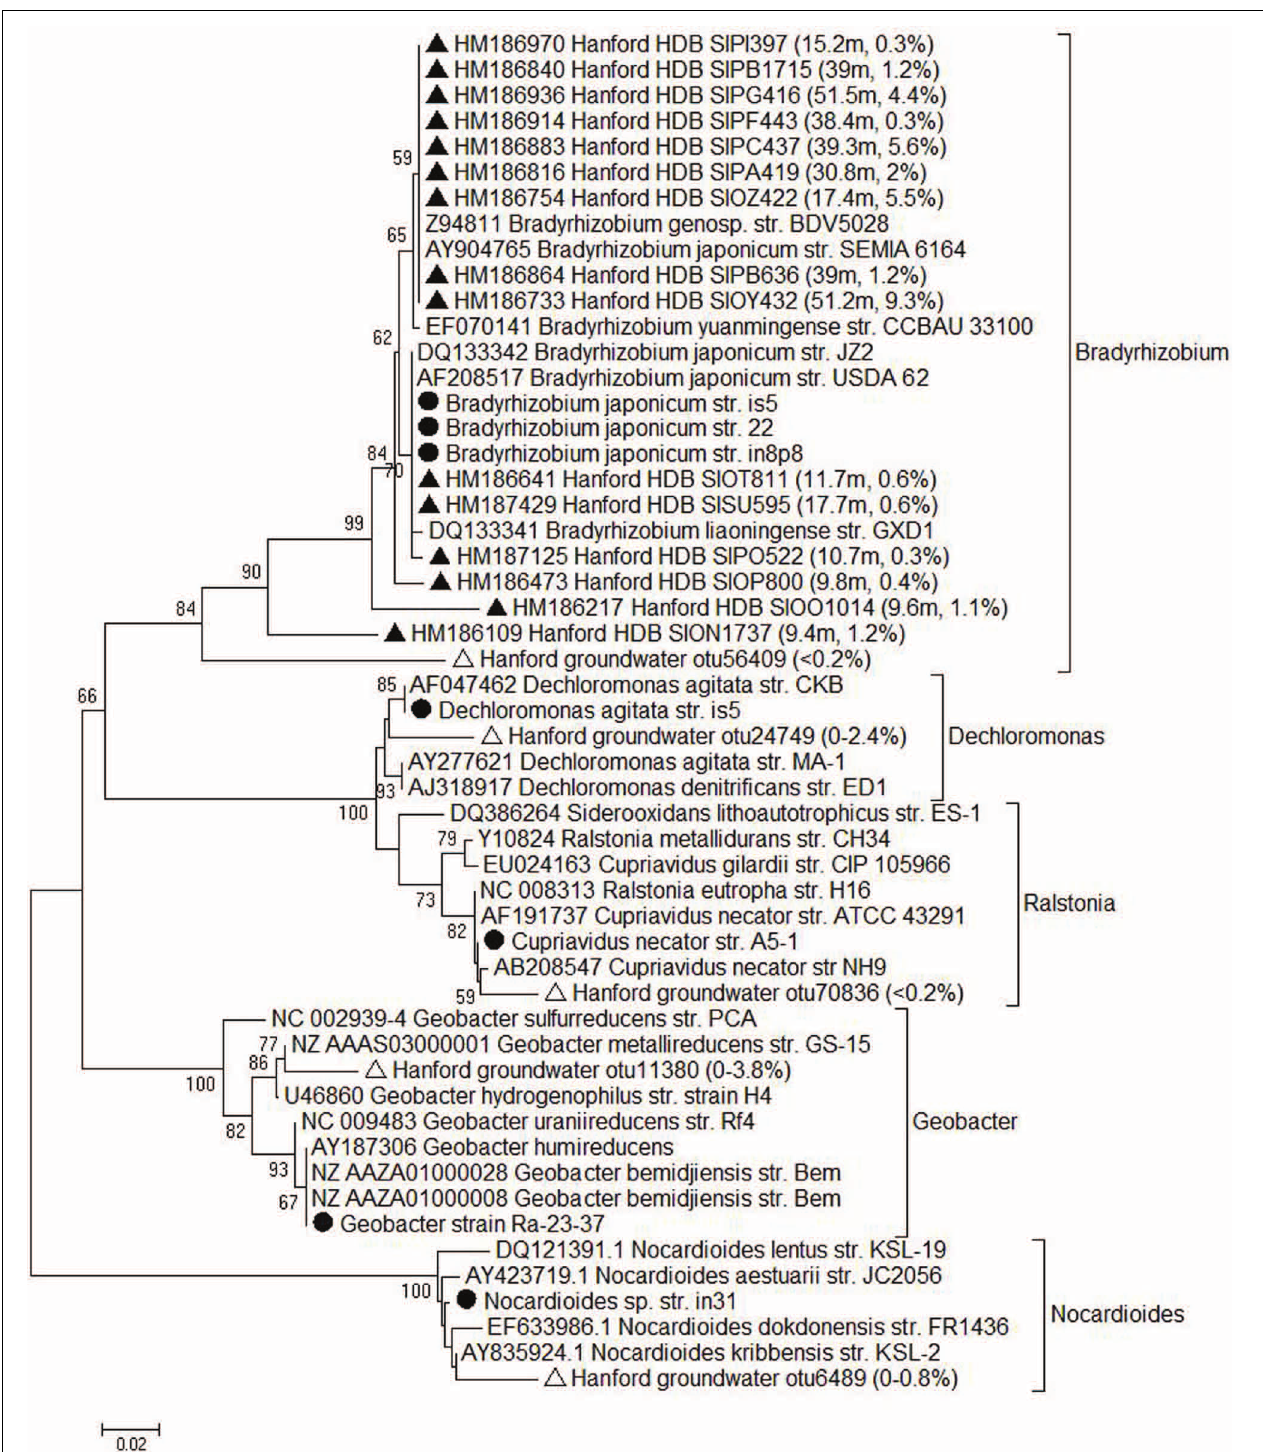
FIGURE 4 | Neighbor-joining tree of16S rRNA gene sequences for the isolates (circles) with the presence of the nearest reference strains and the Hanford sediment (solid triangles) and groundwater (open triangles) clones. Bootstrap values less than 50% were not shown. Numbers in